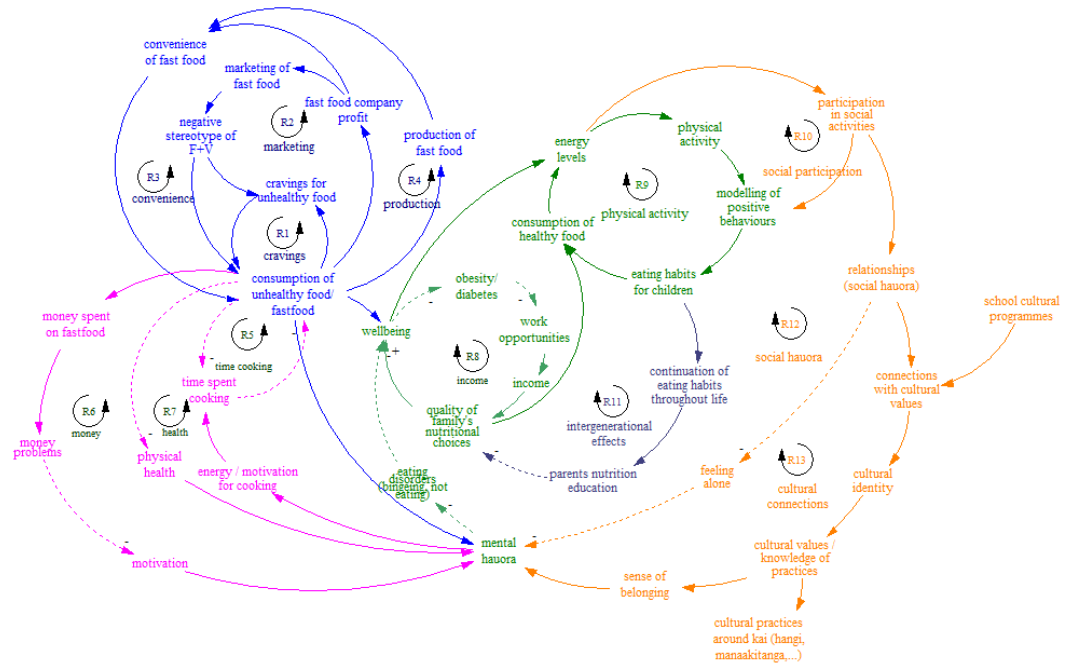
Figure 2. Youth–constructed food systems causal map.